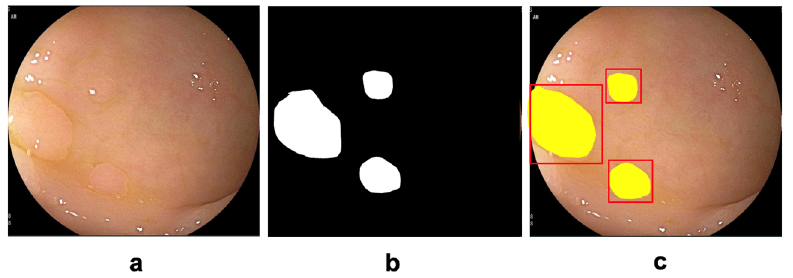
Figure 5. Polyp image samples. ( a ) original image, ( b ) corresponding annotation, and ( c ) detected polyps in the yellow regions.